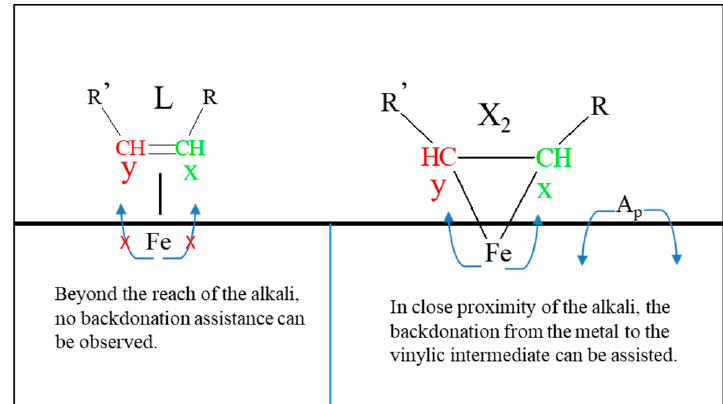
Figure 35. Alkenes are known as π donors. Above represents the Dewar-Chatt-Duncanson model for the orbital orientation between the π orbitals of the alkene and the d orbitals from the metal. The electronic density of the metal will determine the hybridization of the carbon, where the planar olefin adduct (left structure) displays more sp 2 hybridization for the carbon, and the metallocyclopropane exhibits more sp 3 character.